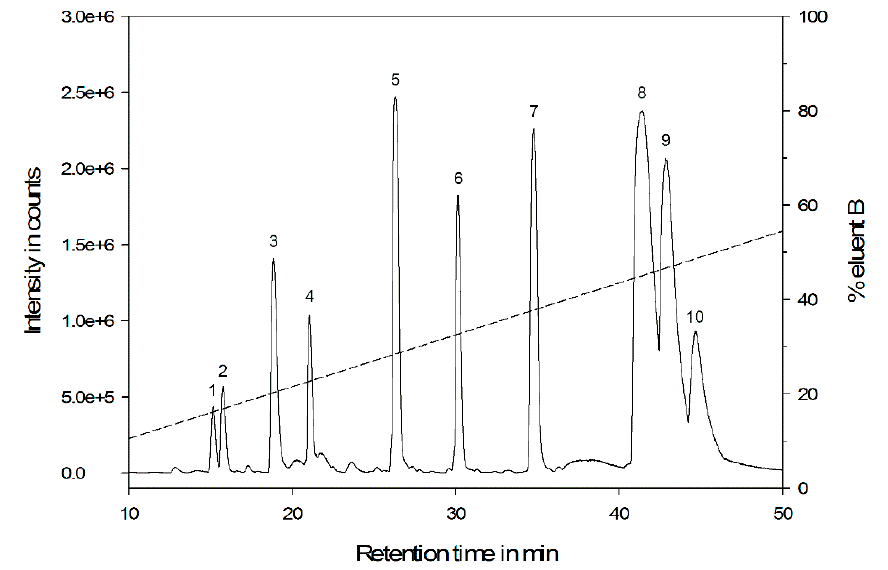
Figure 1. Base peak chromatogram of the venom of the ruby ant M. rubra . Crude venom was separated on a Kinetex C18 (150 mm × 2.1 mm, 2.6 µm, Phenomenex, USA) column using a gradient elution (dashed line) with water + 0.1% formic acid as eluent A and acetonitrile + 0.1% formic acid as eluent B. Mass spectra were recorded on a micrOTOF-QII instrument (Bruker, USA). Detailed information on numbers associated with the peaks is given in Table 1. Table 1. Major peptides with a relative abundance >10% in the venom of the ruby ant M. rubra . Most of the peptides are linear, but reduction and alkylation of crude venom revealed the presence of two peptides with one intramolecular disulfide bond (highlighted in gray). RT: Retention time, MW: Molecular weight, RA: Relative abundance, aa: Amino acid, S-S: Disulfide bridges.